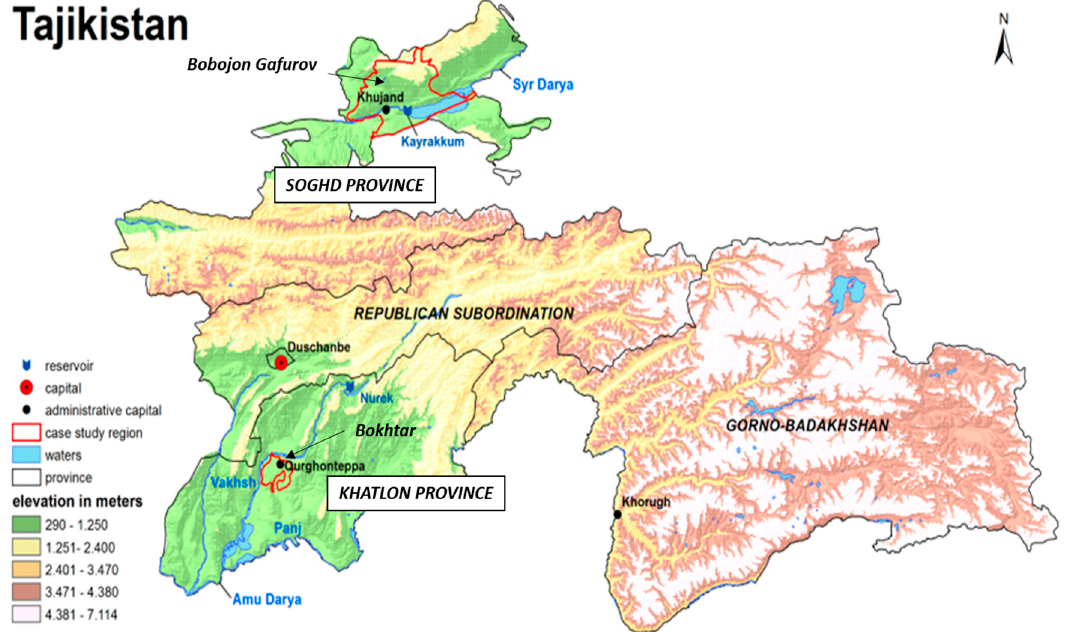
Figure 2. Topographic map of Tajikistan indicating the case study regions. Source: Figure prepared by Neumann and Klümper based on Global Administrative Areas (GADM), version 1 and Data from the Consultative Group in International Agricultural Research—Shuttle Radar Topography Mission (CGIAR SRTM); http://srtm.csi.cgiar.org/.